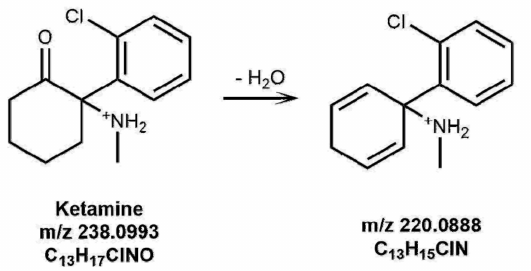
Figure 1. Proposed structures of ketamine (KET) photoproducts formed in a water solution upon irradiation for 3 h.